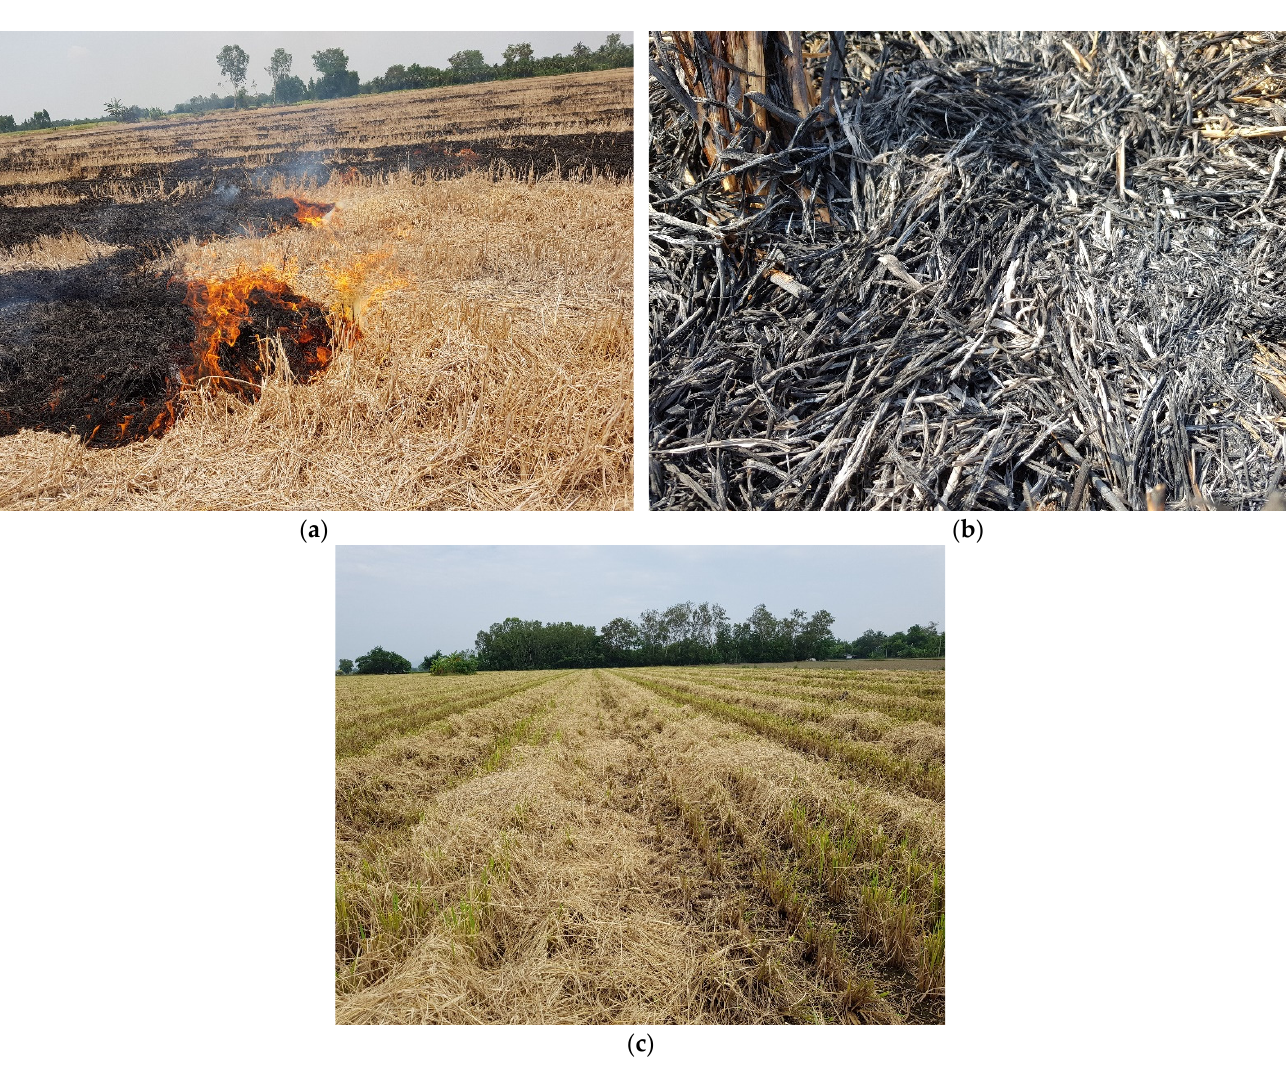
Figure 1 . Rice straw and stubble burning practices : ( a ) during burning, ( b ) postburning, and ( c ) one Figure 1. Rice straw and stubble burning practices: ( a ) during burning, ( b ) postburning, and ( c ) one year after burning . Photos were taken by Noppol Arunrat . year after burning. Photos were taken by Noppol